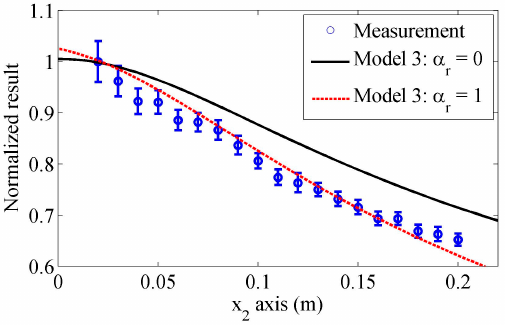
Figure 14. Measured normalized results in the propagation distance and comparisons with the predictions by the Model 3 using different attenuation coefficients.